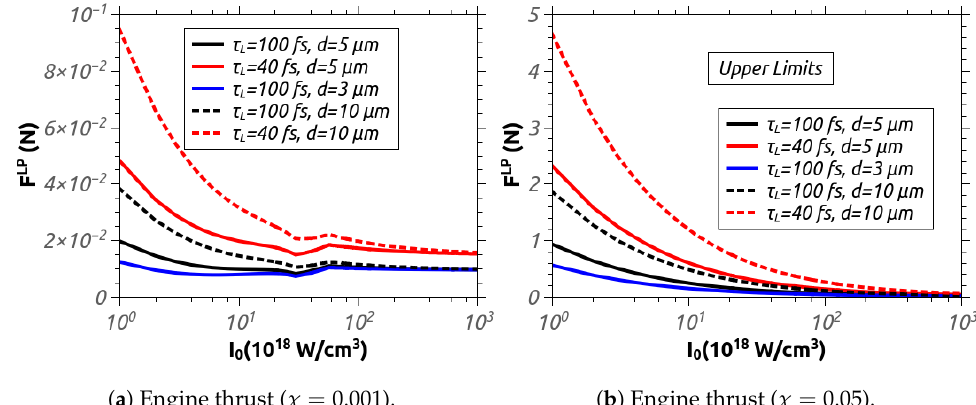
Figure 7. Engine thrust as a function of laser intensity at fixed pulse energy ε L = 10 3 J. A uniformly ionized C 6 + target with a density of ρ = 1 g/cm 3 has been considered. Different target thickness and pulse duration have been analyzed. The laser repetition rate is fixed by ν L = 1